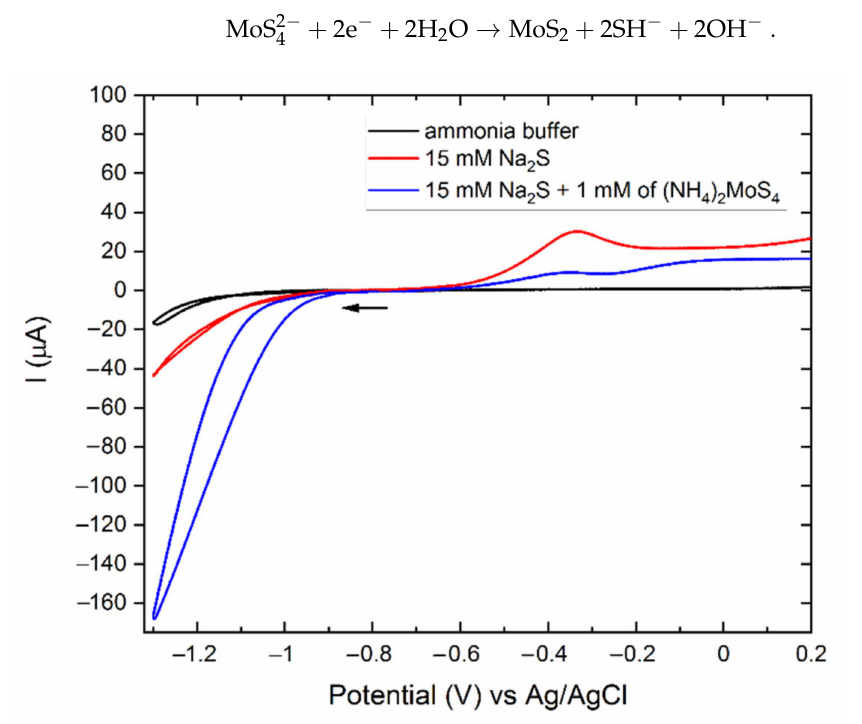
Figure 1. CVs of ammonia buffer (black), 15 mM Na 2 S in ammonia buffer (red), 1 mM (NH 4 ) 2 MoS 4 and 15 mM Na 2 S in ammonia buffer on n -Si (100) from –0.75 V to 0.2 V (blue), scan rate 10